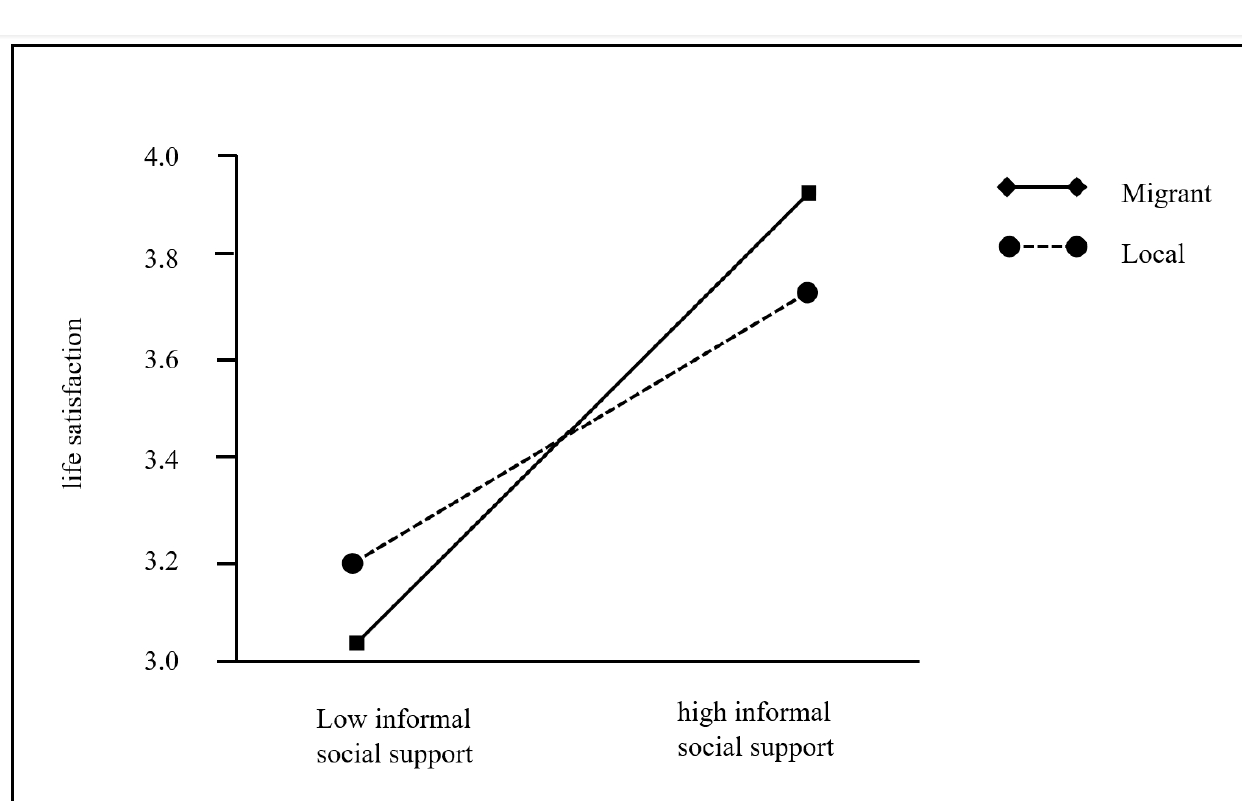
Figure 2. Hukou as a moderator of the relationship between informal social support and life satisfaction.